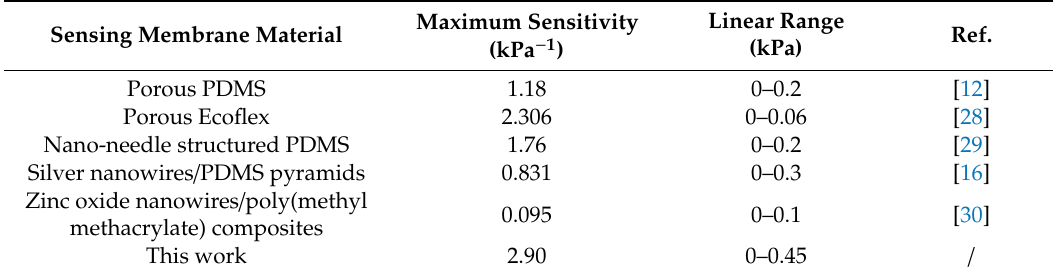
Figure 6. Capacitance change of the flexible sensors with composite dielectric layer based on various aspect ratios of CNTs under pressure. Table 4. The main characteristics of various capacitive-type pressure sensors.